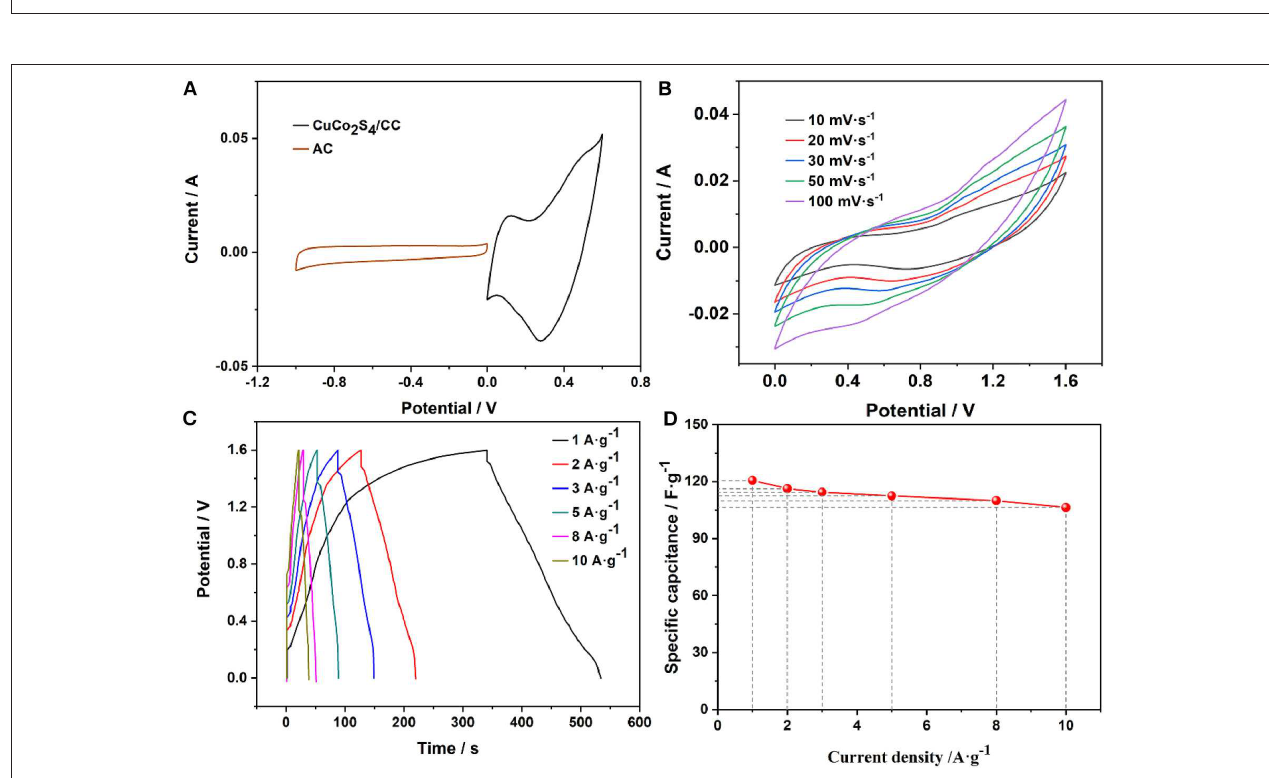
FIGURE 5 | CV curves of the positive and negative (A) ; CV curves (B) ; GCD curves (C) ; and the rate characteristics (D) of the device.